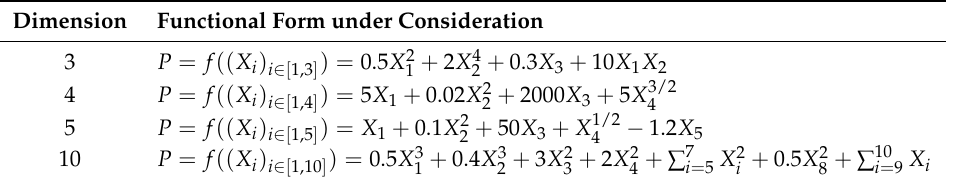
Table 6. Polynomials used as proxy functions to obtain the overall insurer’s loss.